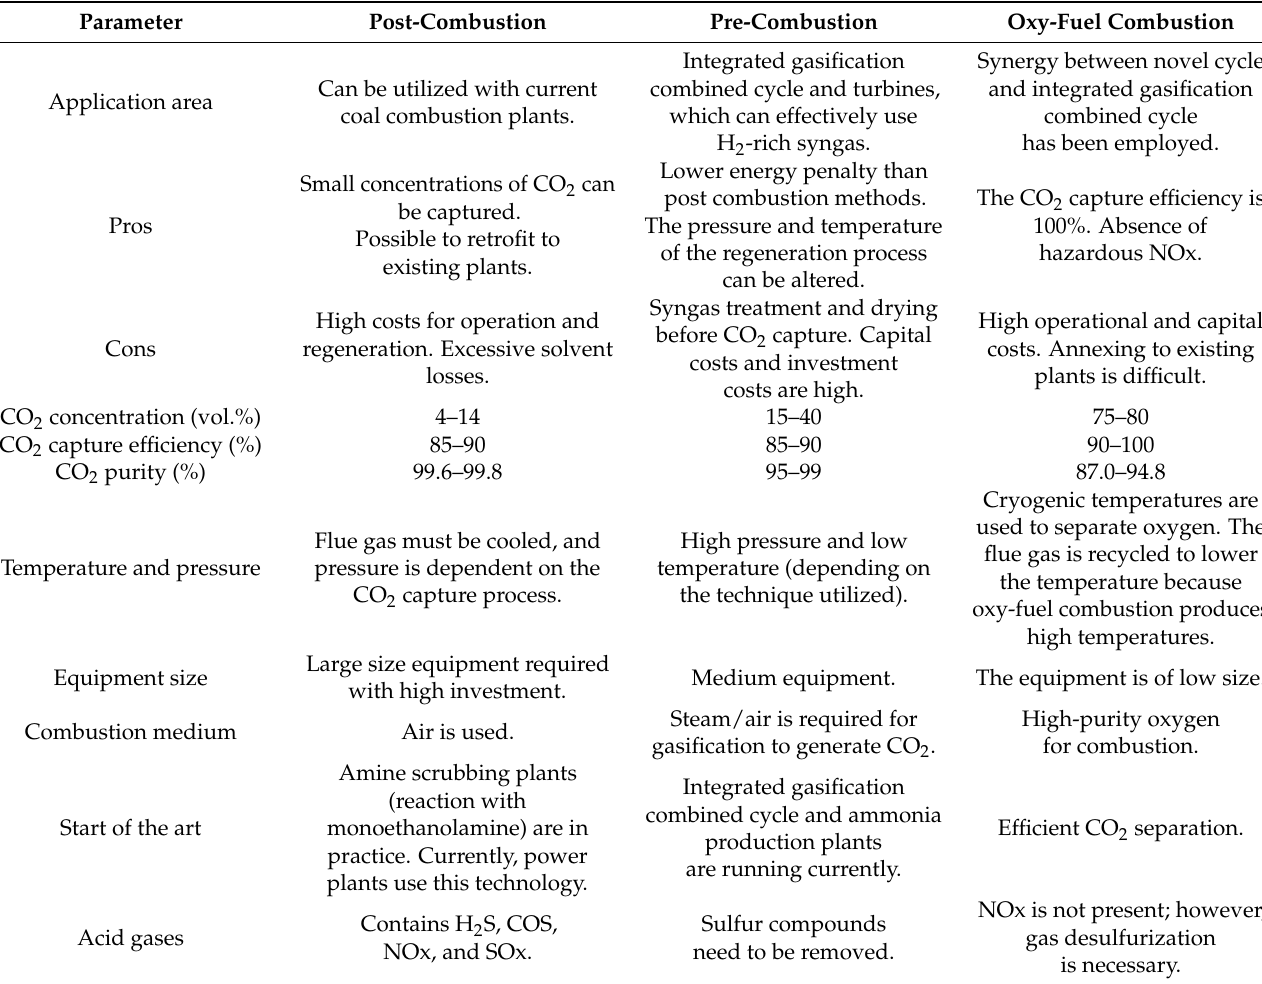
Table 1. Comparison of various CO 2 capture technologies [37].